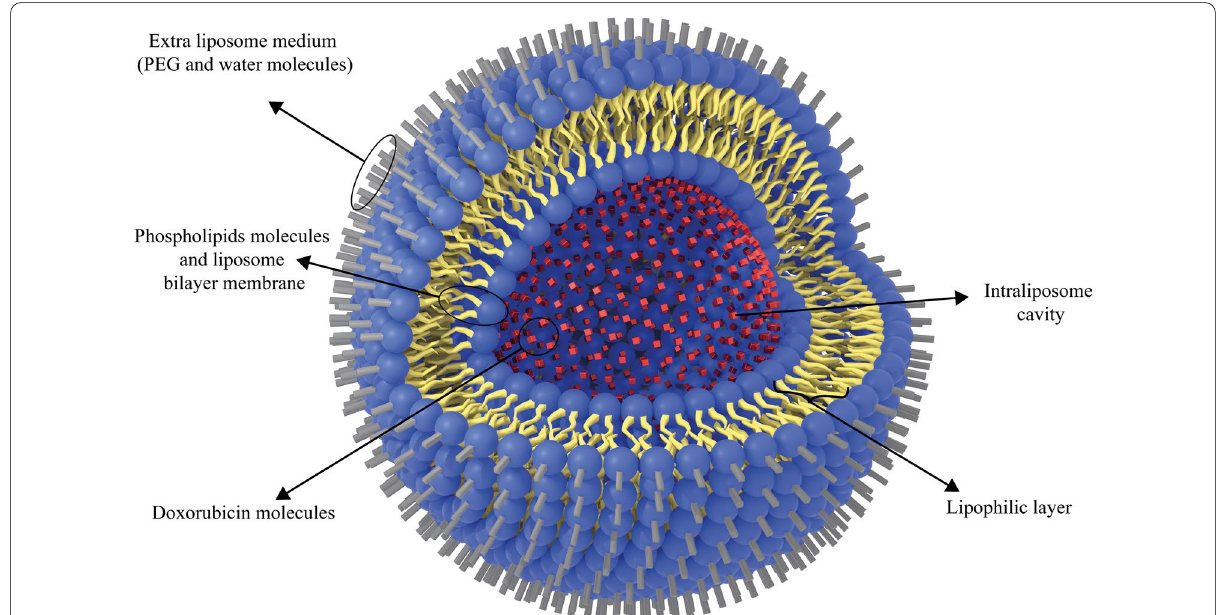
Fig. 9 The schematic structure of Doxil drug. Doxorubicin drug molecules are entrapped in the hydrophilic cavity of unilamellar PEGylated